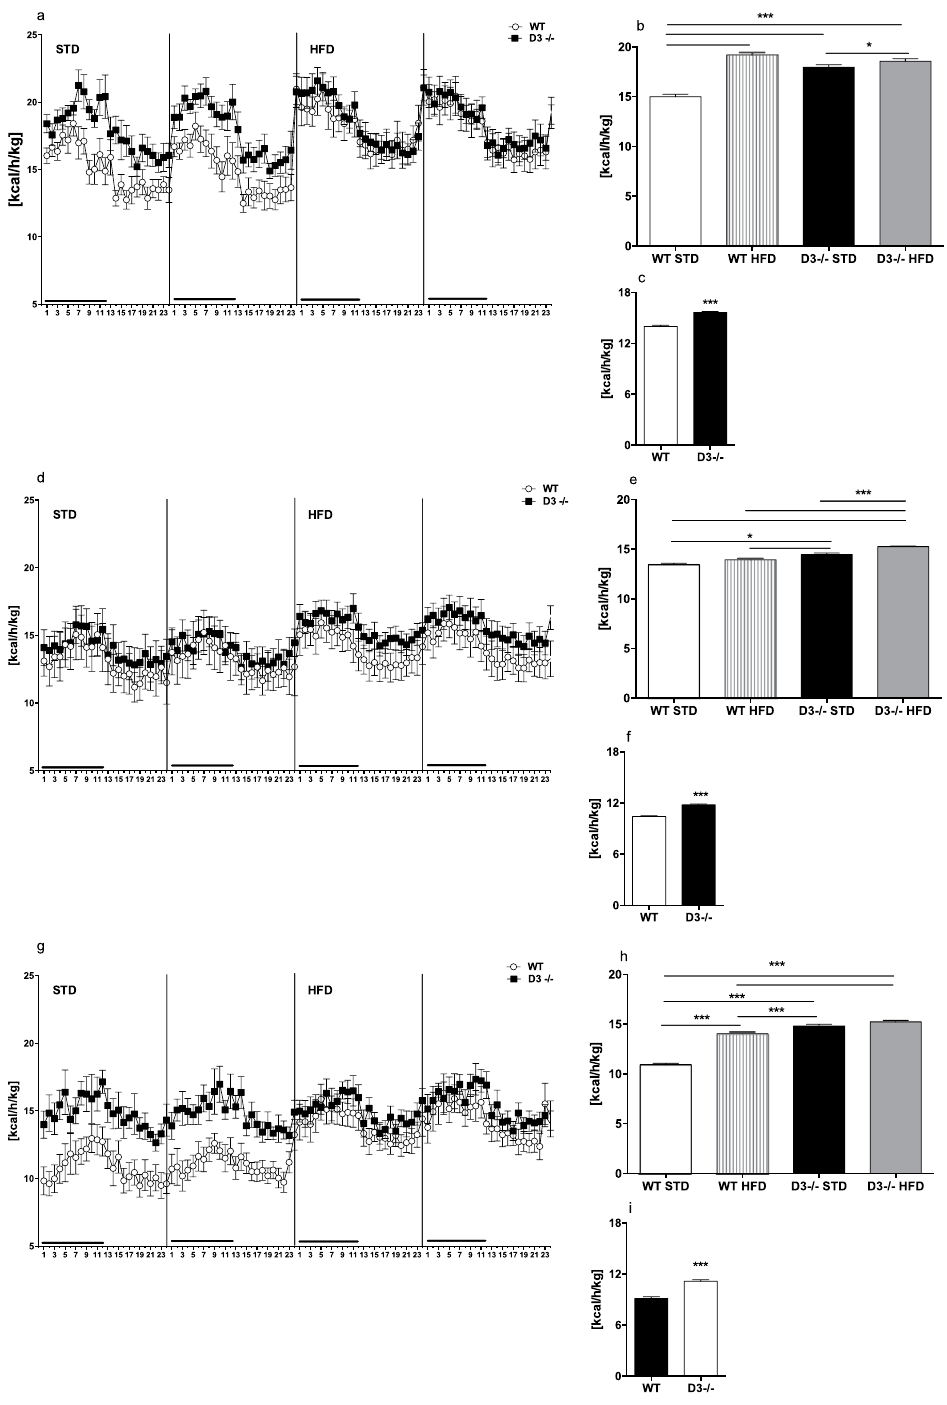
Figure 1. Energy expenditure. Upper ( a – c ), middle ( d – f ), and lower ( g – i ) panels are referring to juvenile (D3 − / − , n = 12; WT, n = 10), adult (D3 − / − , n = 11; WT, n = 7) and aged (D3 − / − , n = 8; WT, n = 9) mice, respectively. ( a , d , g ) Four days of continuous indirect calorimetry recording. Mean EE is reported in terms of heat (kcal/kg) emitted for each hour per day (24 time bins of 1 h each) in STD (two days) or HFD (two days) feeding conditions. The horizontal black bar at the beginning of each 24hrs cycle indicates the dark cycle period. ( b , e , h ) Mean of two days of EE produced by WT and D3 − / − mice in STD or HFD feeding conditions. Two-way ANOVA analysis of EE data showed significant main effects for groups and time in juvenile (groups: F 3,1730 = 135.9, p < 0.0001; time: F 46,1730 = 10.17, p < 0.0001), adult (groups: F 3,2201 = 31.61, p < 0.0001; time: F 70,2201 = 1.79, p < 0.0001) and aged mice (groups: F 3,1410 = 183.9, p < 0.0001; time: F 46,1410 = 3.67, p < 0.0001). The analysis showed also significant groups x time interactions in juvenile, adult and aged mice (F 138,1730 = 1.40, p < 0.001; F 210,2201 = 1.19, p < 0.001; F 138,1410 = 1.35, p < 0.001, respectively). Post hoc test for multiple comparisons data were performed by Bonferroni’s test. The bars above histograms depict the